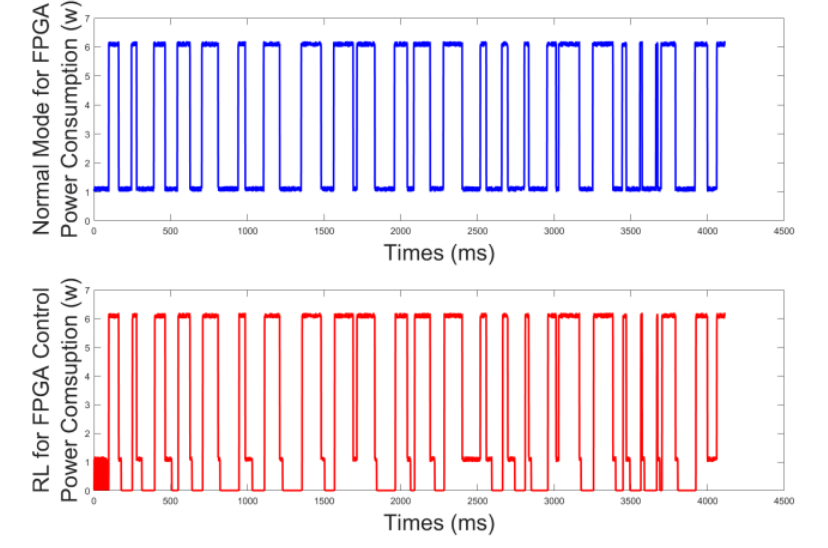
Figure 4. Comparison of power consumption effects with and without RL